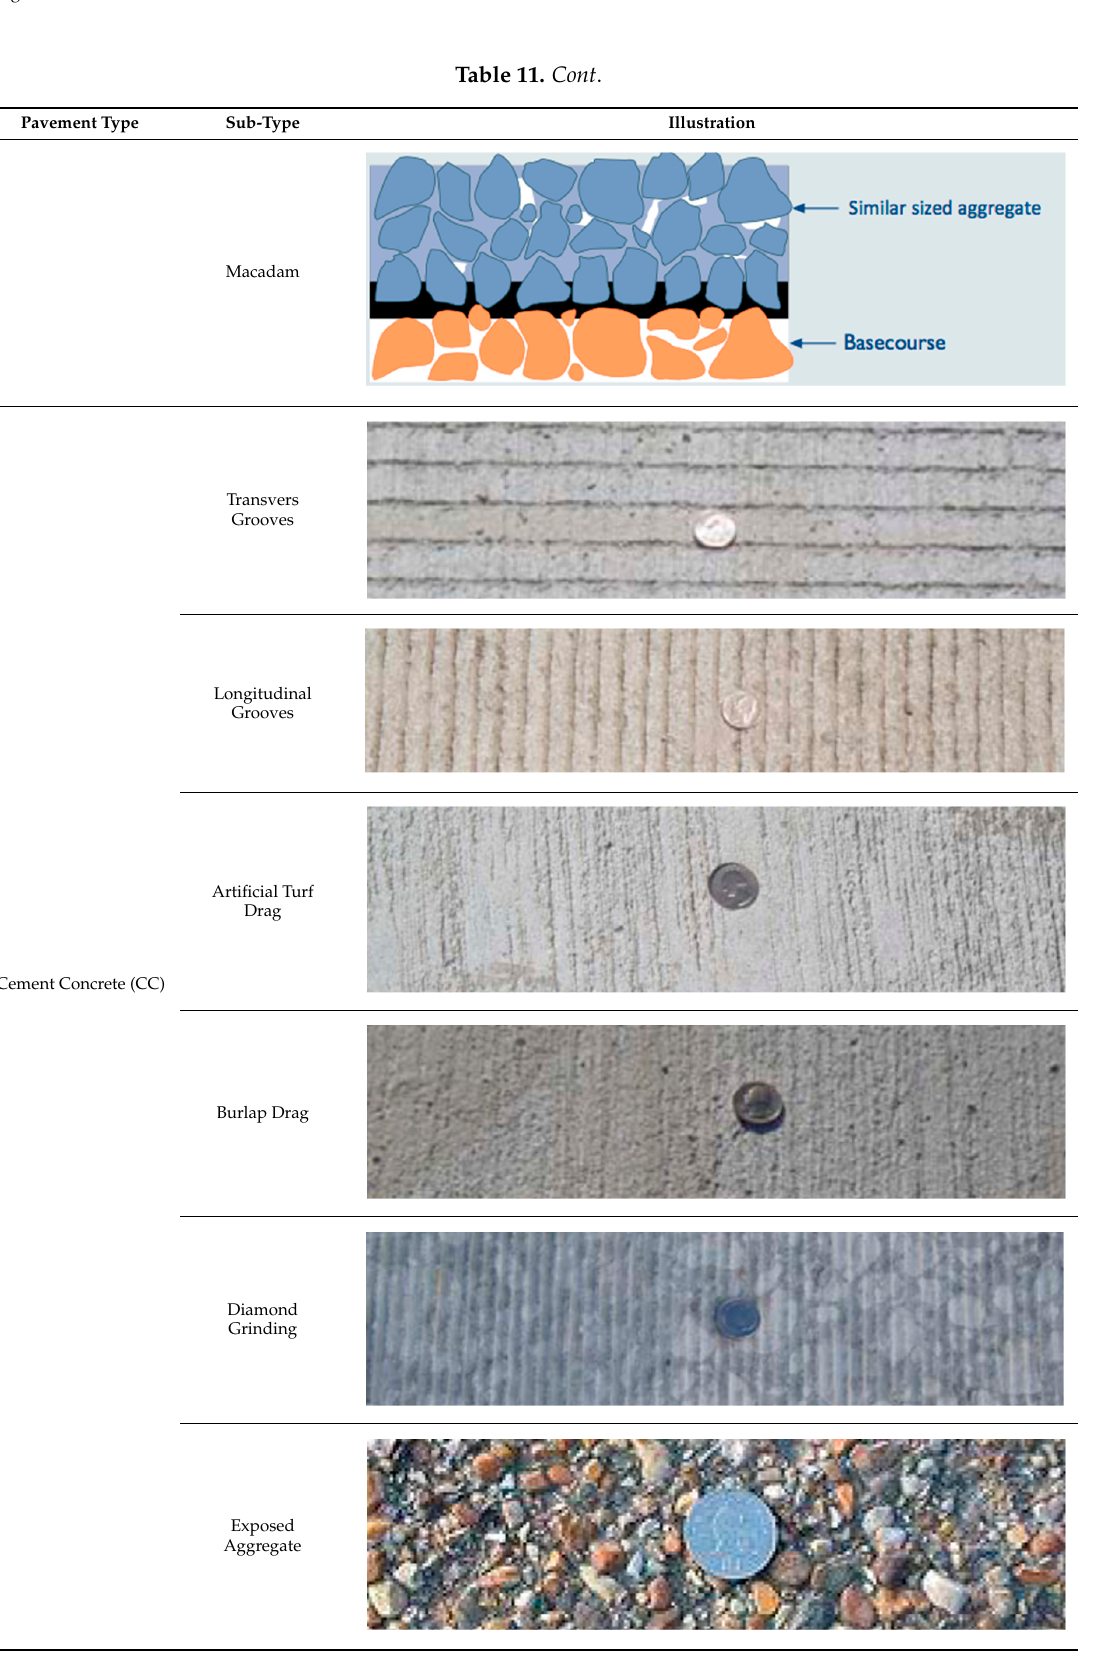
Figure 21. Acoustic performances of typical pavements in Virginia (modified from McGhee, 2012 [184], Page 14; reprinted under fair use provision). The pavement related parameters could be categorized into primary parameters, secondary parameters and tertiary parameters. The primary parameters are those for pavement design or mixture properties, such as grading size distribution, content of binder and thickness; the secondary parameters are characteristics that show up and remain relatively constant after the pavement is built, such as porosity, texture and impedance (Li et al., 2009 [186]); the tertiary parameters are those that might change with time, such as wetness, wear/age, and surface rating. 5.1. Texture The pavement texture is acknowledged to have a significant influence on tire–pavement interaction noise where the tread pattern is not too aggressive (Klein and Cesbron, 2016 [187]; Li, 2017 [188]). Pavement texture is defined as “the deviation of a pavement surface from a true planar surface” within a specific wavelength range (ISO, 1997 [189]). Among the pavement related parameters, pavement texture has the greatest influence on TPIN (Huschek, 1996 [190]) and is included in nearly all TPIN models. However, texture cannot be described using one single metric. It is divided into a group of parameters representing different aspects of texture based on the wavelength of the texture. They have different impacts on TPIN and other tire characteristics, as shown in Table 12 (Dimitri, 2012 [91]; Wayson, 1998 [191]). Table 12. Texture parameters and influence on tire/pavement characteristics (red ↑ indicates increase, green ↓ indicates decrease and blue • indicates complex) (modified from Dimitri, 2012 [91]; Wayson, 1998 [191]).